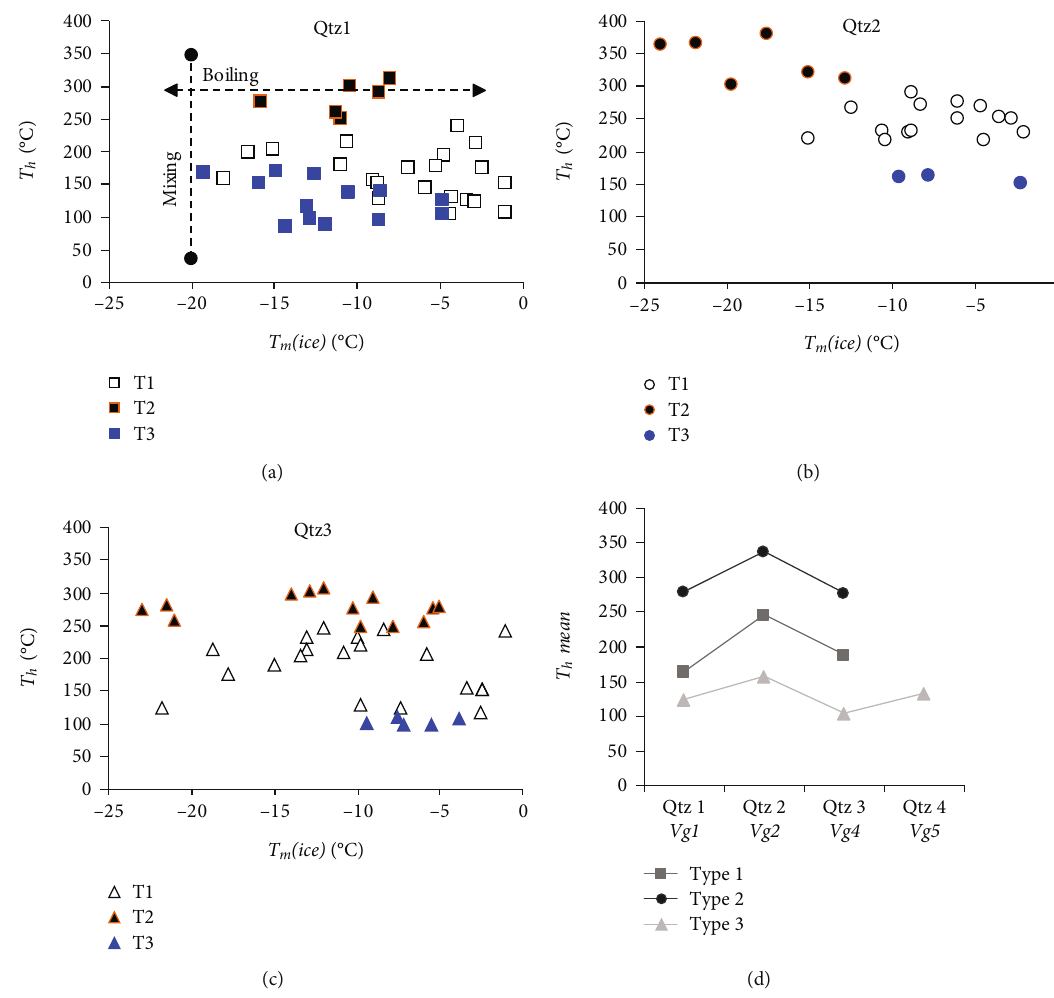
T h vs. m ð ice Þ binary diagram. (a) ). (c) Qtz3-mineralised vein (vg ). (d) T h mean of all fl uid 2 4